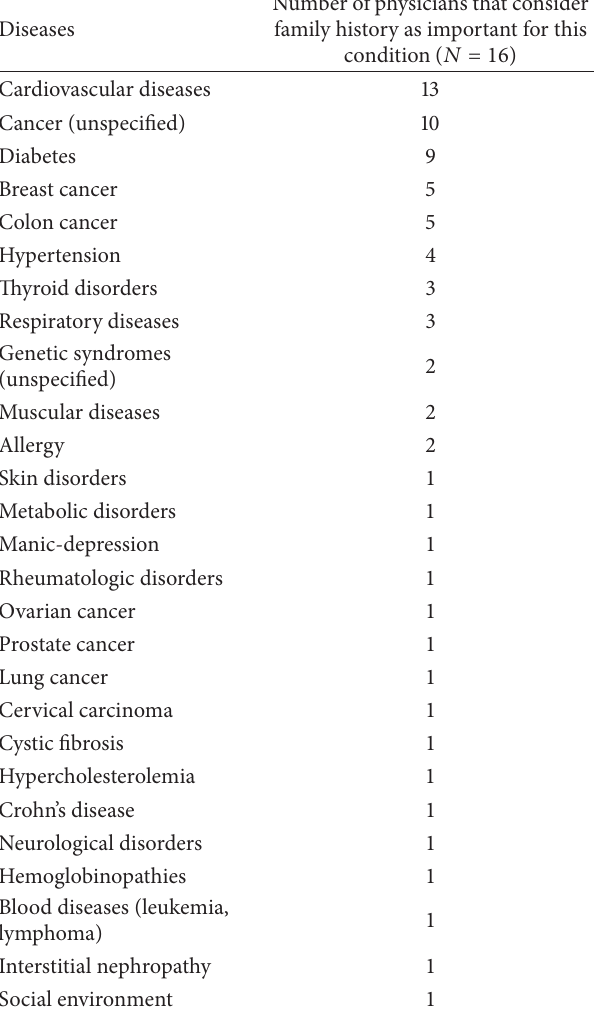
Table 2: Diseases in which the family history is considered impor- tant by the